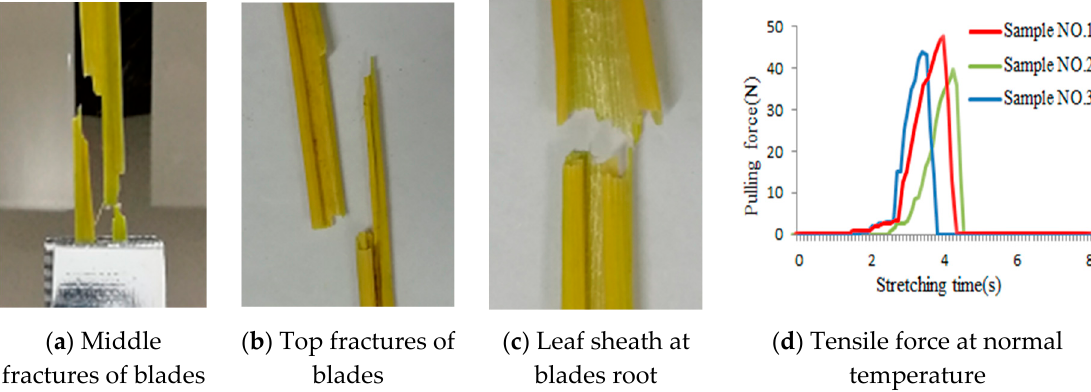
Figure 10. Tensile fracture modes and tensile force curves of stretching blades.